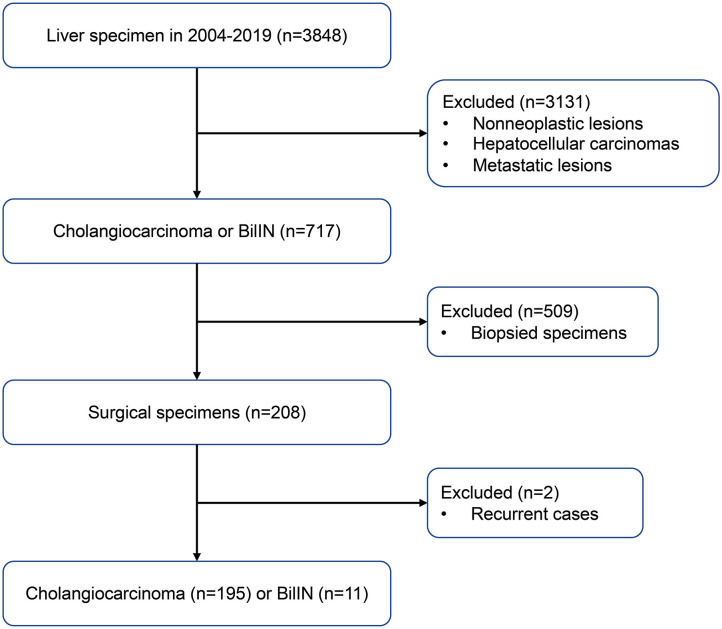
Case selection flow with inclusion and exclusion criteria.